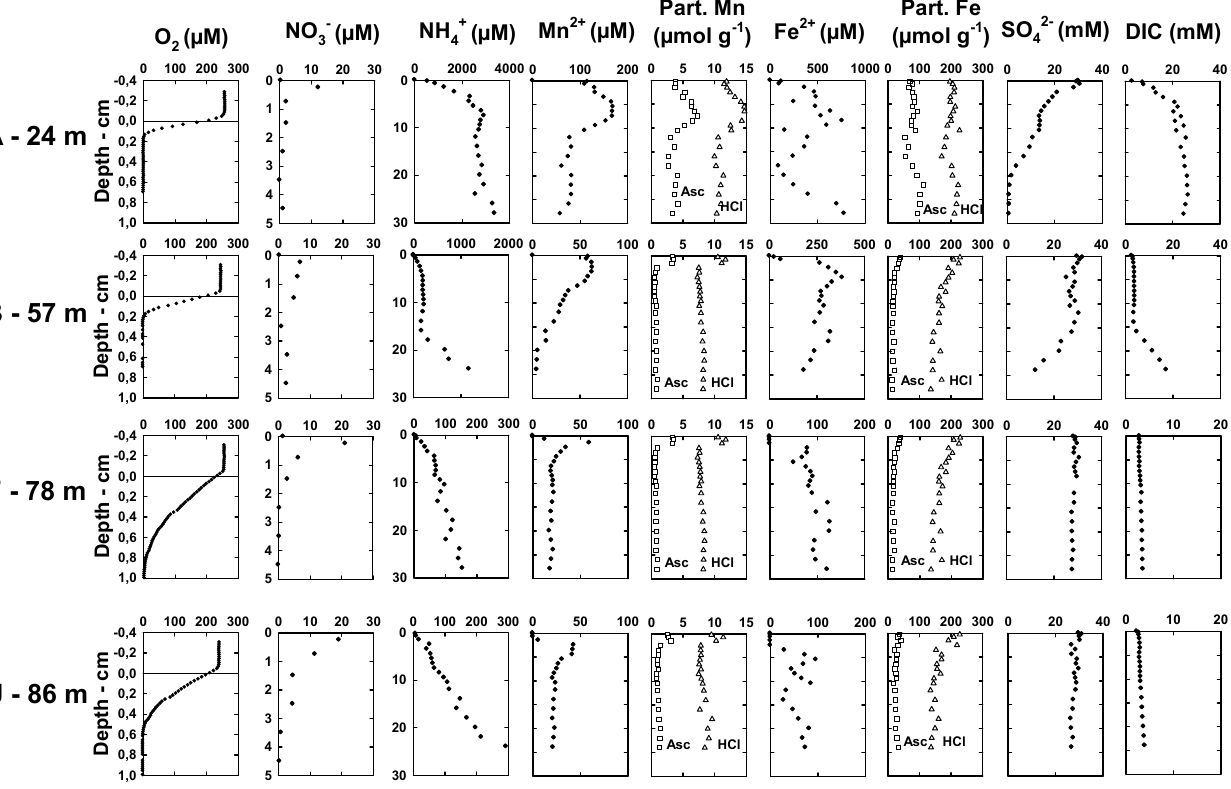
Fig. 2. Biogeochemical profiles in sediments from stations A, B, F and J: mean oxygen, nitrate, ammonium, dissolved manganese and iron, particulate manganese and iron extracted with HCl and an ascorbate solution, sulphate and DIC. Note that different scales are used for different stations.